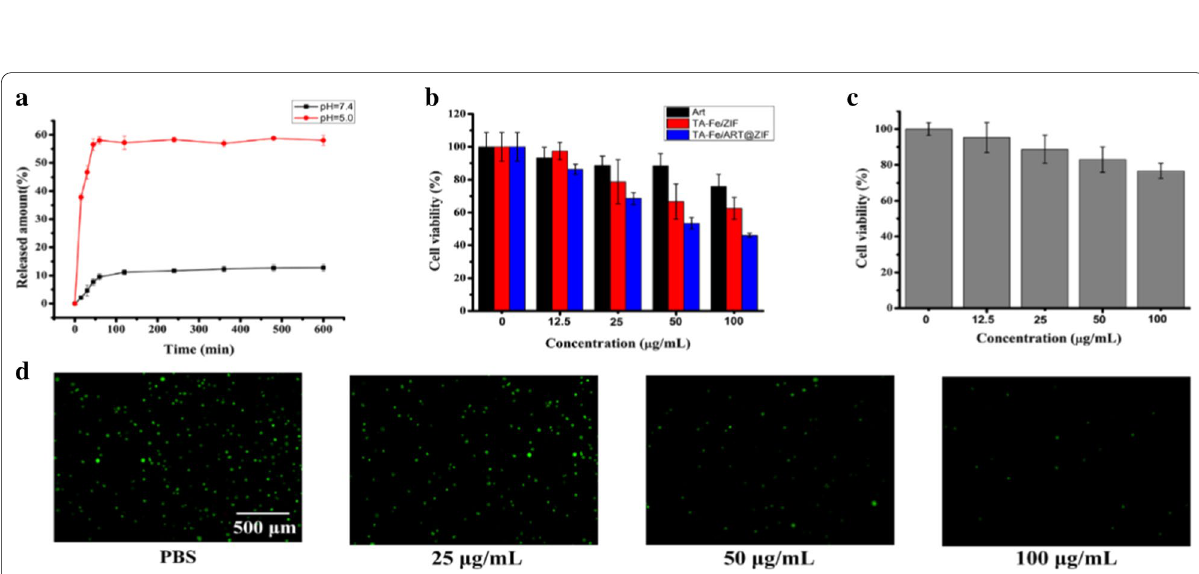
Fig. 4 a In vitro release of ART from TA-Fe/ ART@ZIF nanoparticles in pH 7.4 and 5.0. b The cytotoxicity of ART, TA-Fe/ZIF, and TA-Fe/ART@ZIF nanoparticles in MDA-MB-231 cells at 0, 12.5, 25, 50, and 100 μg/mL. c Viability of L929 cells treated with TA-Fe/ART@ZIF at different concentrations. d Calcein-AM staining of MDA-MB-231 cells treated with TA-Fe/ART@ZIF nanoparticles at concentrations of 0, 25, 50, and 100